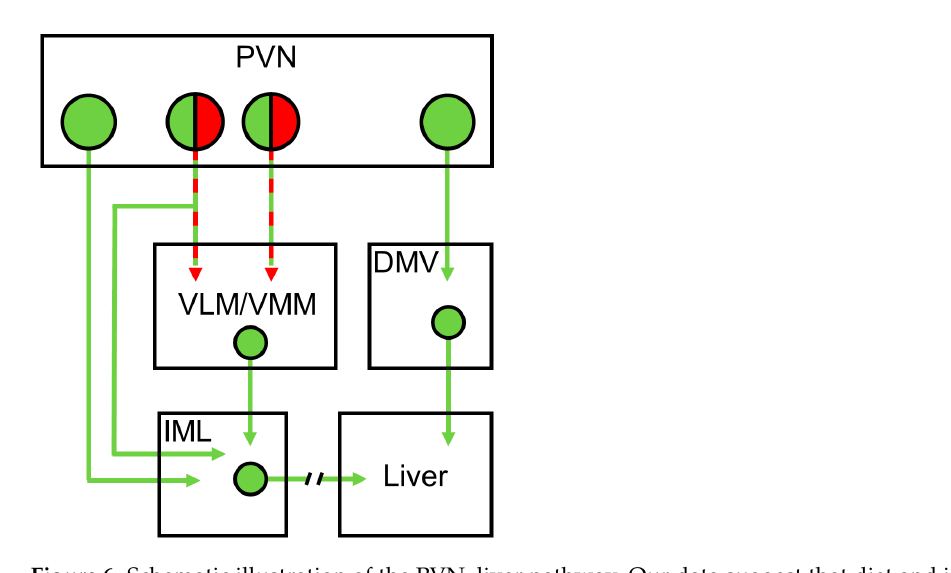
Figure 6. Schematic illustration of the PVN–liver pathway. Our data suggest that diet and insulin have differential effects on liver-related neurons depending on their location and projections. Green: liver-related neurons, green-red: liver-related PVN neurons with projections to the VLM/VMM. DMV: dorsal motor nucleus of the vagus, PVN: paraventricular nucleus, VLM/VMM: ventrolateral and ventromedial medulla.